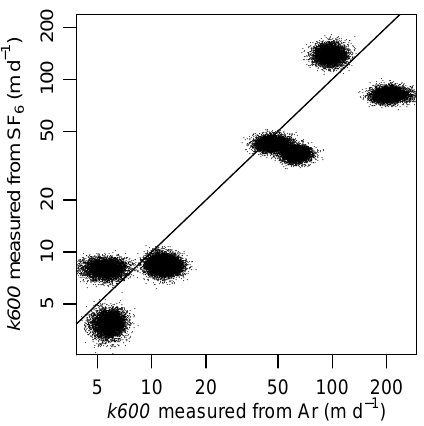
Figure 4. Gas exchange velocity increased as a power relationship with stream slope. Equation is ln (k 600 ) = 1 . 055 × ln ( slope ) + 6 . 90. Error bars are the 95% credible